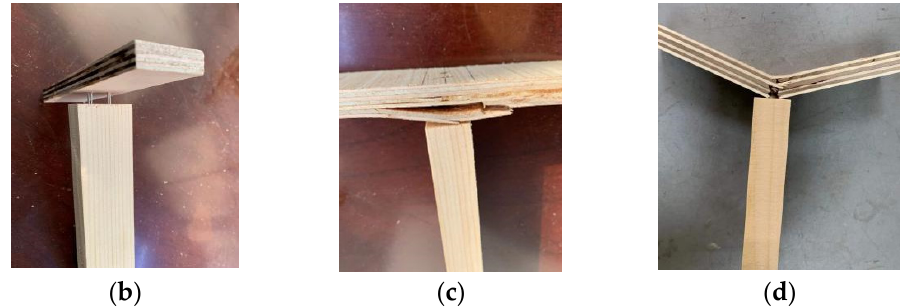
Figure 4. Wood joint failure mode: ( a ) staple legs are pulled out; ( b ) staple legs are pulled out; ( c ) cracks in the middle of the plywood; and ( d ) broken plywood.